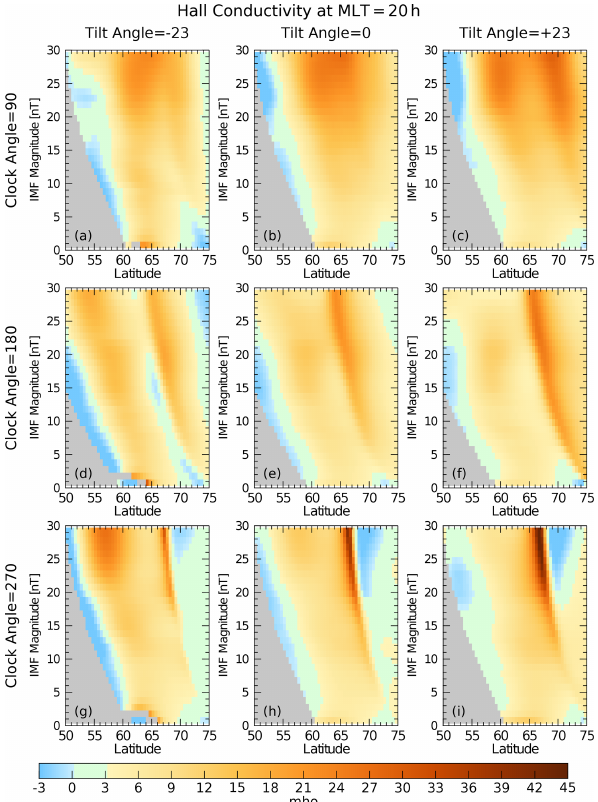
Figure 8. Pedersen conductivity as a function of latitude from 50 to 75 ◦ at 20:00MLT. The format of the graph is the same as in Fig. 6, with only a change in the MLT.